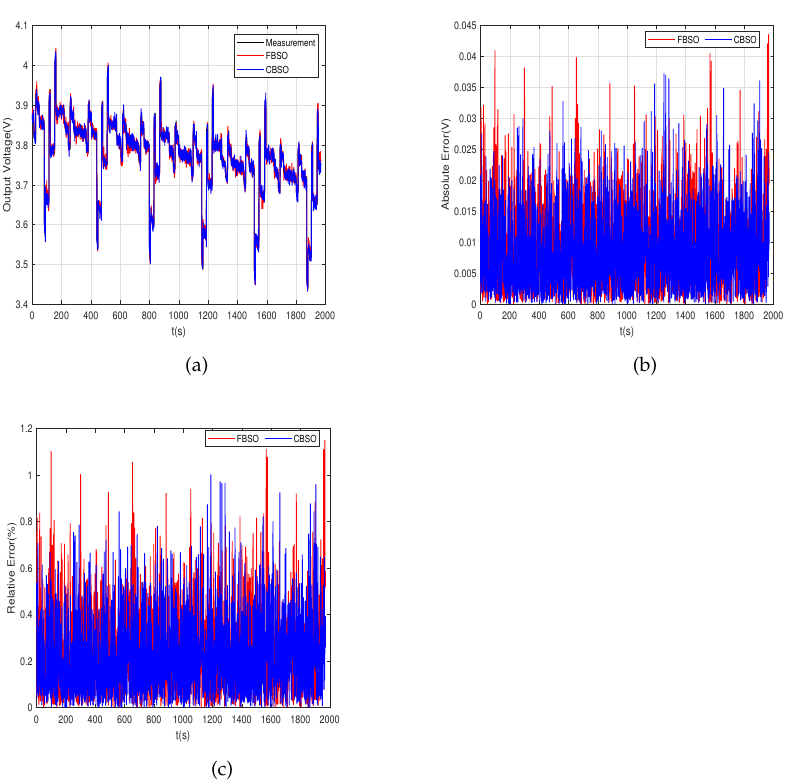
Figure 3. ( a ) Model accuracy verification with the FBSO and CBSO; ( b ) output terminals voltage absolute error; ( c ) output terminals’ voltage relative